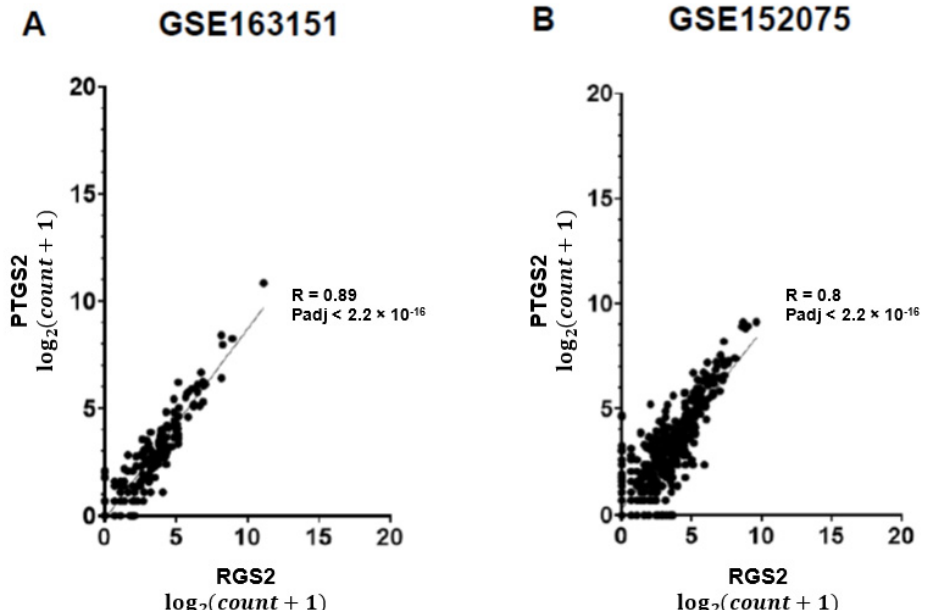
Figure 3. Positive correlation between expression levels of RGS2 and PTGS2 from RNA-sequencing of nasopharyngeal swabs. Spearman correlations are shown for ( A ) dataset GSE163151; ( B ) dataset GSE152075.